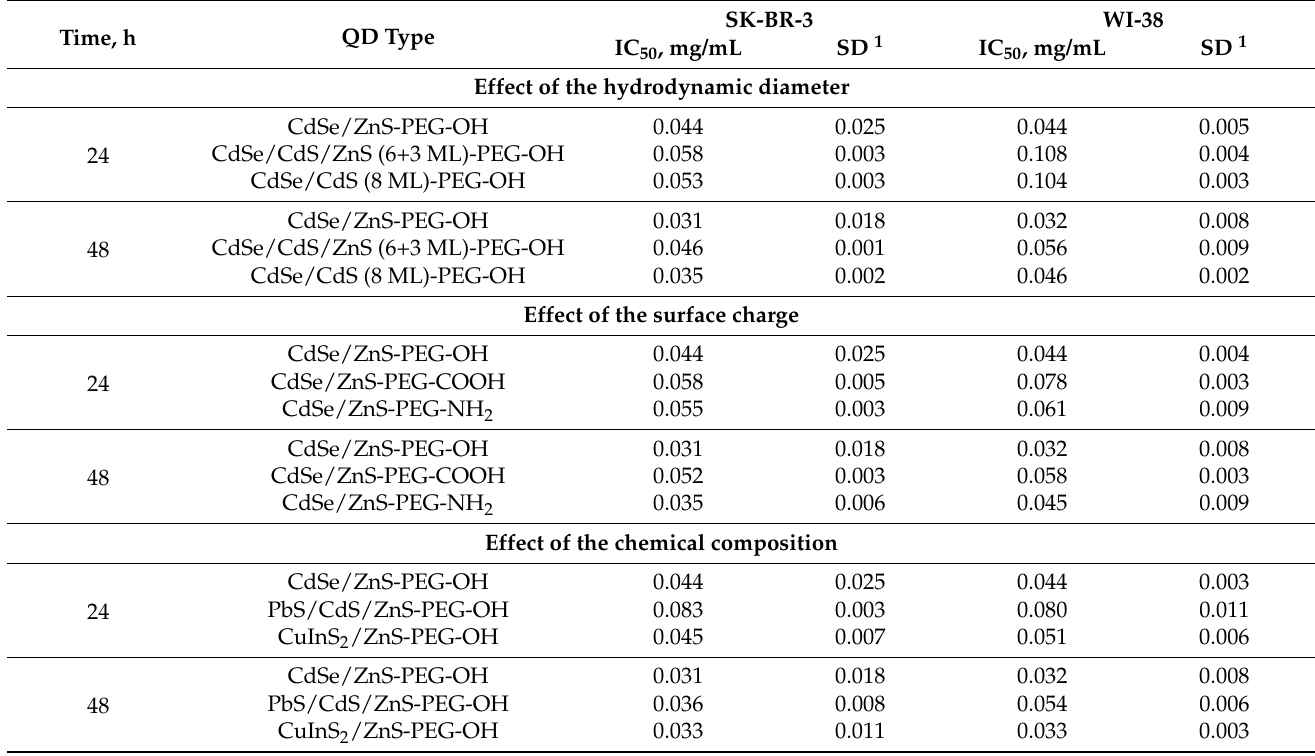
Table 3. Effects of the parameters of QDs of different types on their IC 50 for SK-BR-3 human breast cancer cells and WI-38 human fibroblasts.